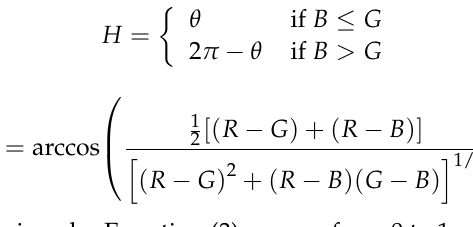
Figure 4. Biconical HSI color space model.